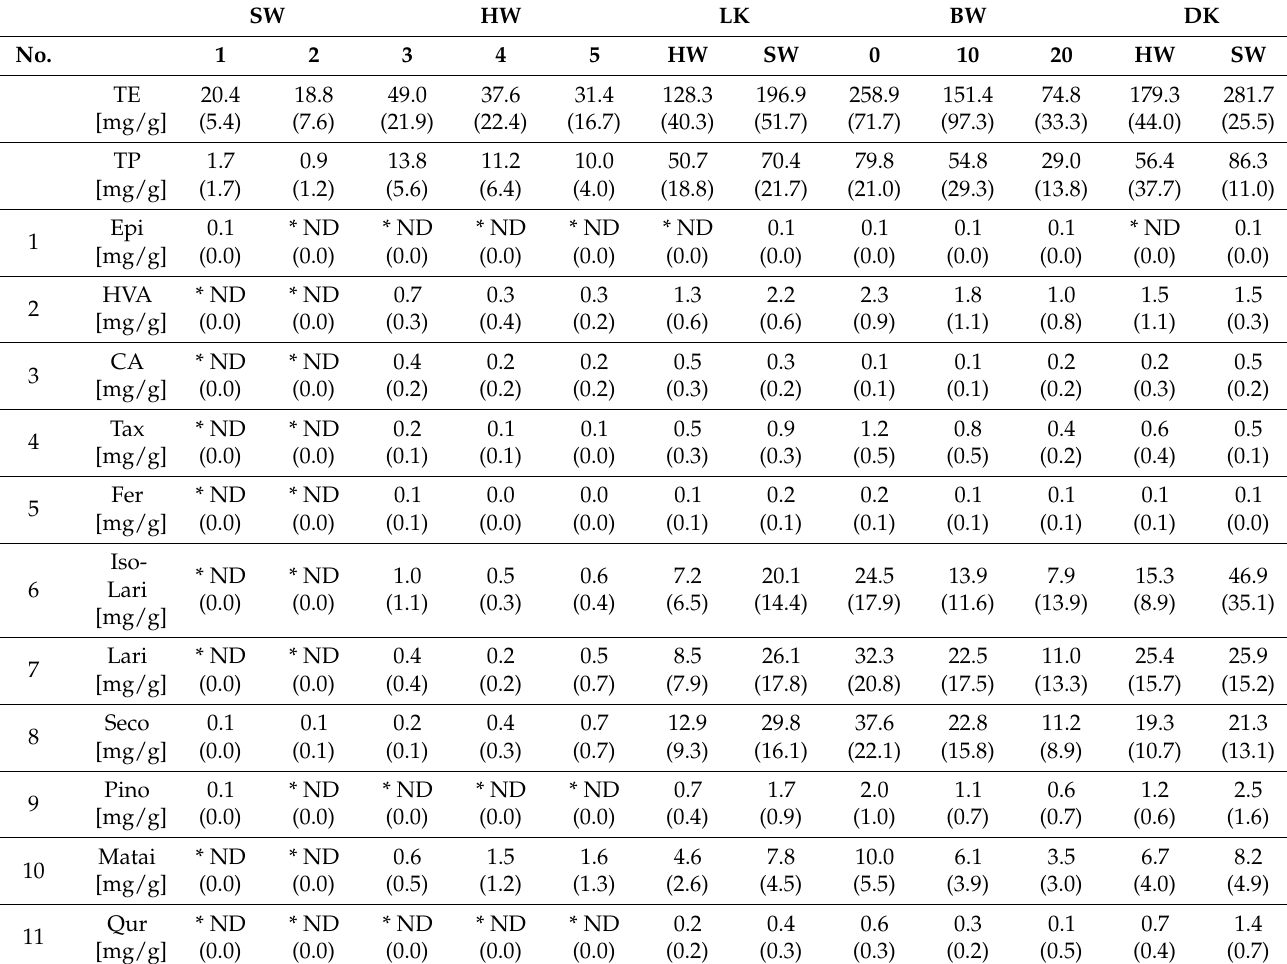
Table 3. Contents of total extractives (TE), total phenols (TP) and the identified phenolic compounds in samples of sapwood (SW), heartwood (HW), knotwood (LK and DK), and branchwood (BW) of silver fir ( A. alba ). The results in the table are presented as average values, with standard deviations (in